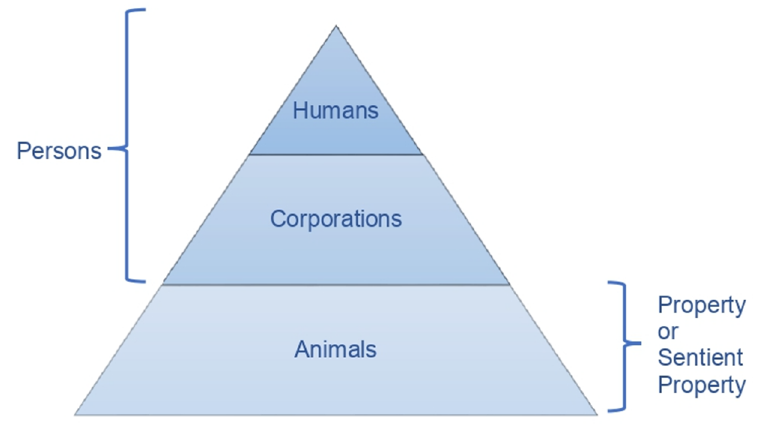
Figure 2. Animals’ Current Legal Regulation.